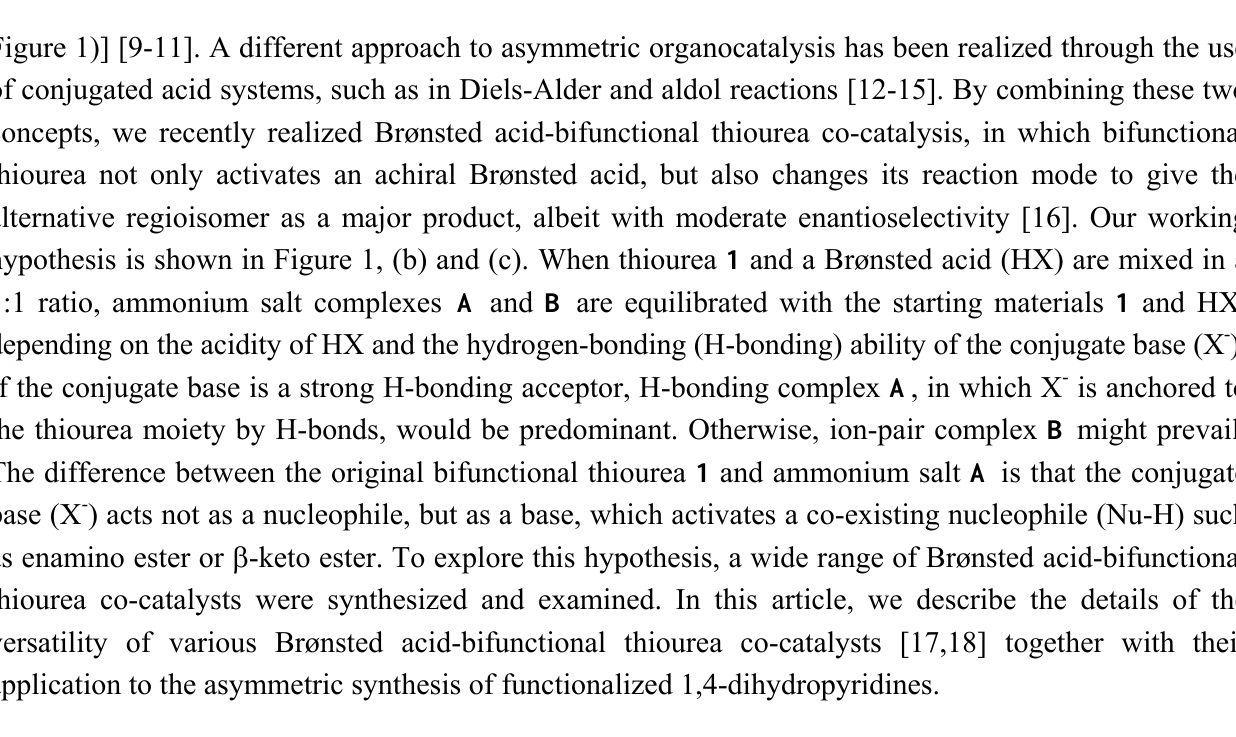
Figure 1. Proposed dual activation mode of